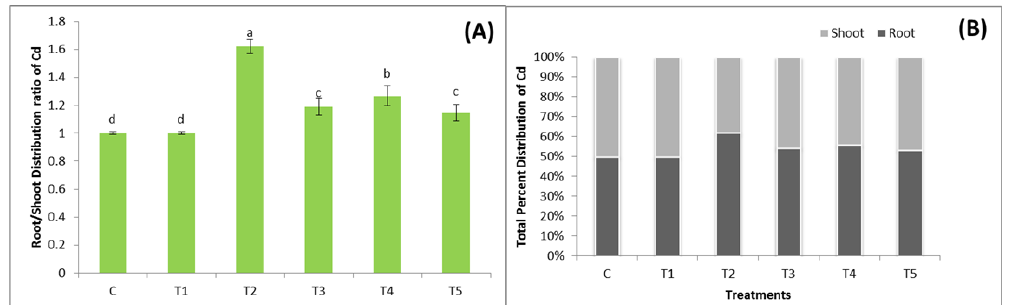
Figure 4. Total % distribution of Cd in plants ( A ) and root/shoot distribution of Cd ( B ) of A. rosea plants under Cd and citric acid application. The bars indicate mean values ± standard error. Where T1 = 5mM.kg -1 CA, T2 = 100 mg.kg -1 Cd, T3 = 100 mg.kg -1 + 5 mM.kg -1 , T4 = 200 mg.kg -1 Cd, and T5 = 200 mg.kg -1 + 5 mM.kg -1 . The different lowercase letters on the vertical bars represent significant differences among the treatments at p < 0.05.